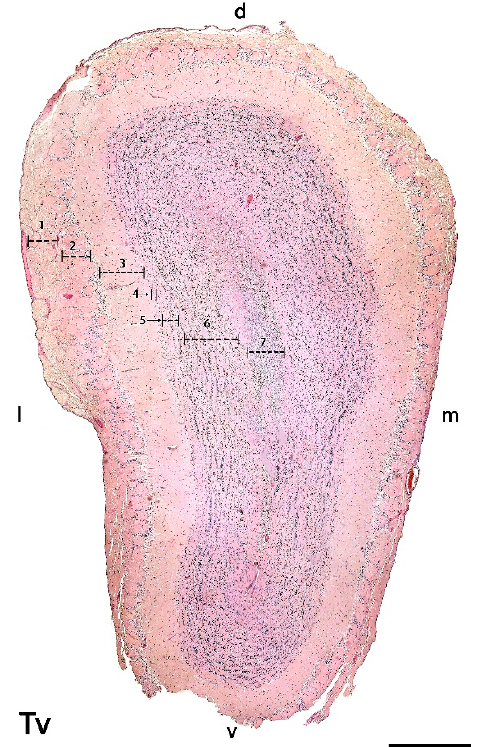
Figure 2. Transverse section of the main olfactory bulb of the meerkat stained by hematoxylin-eosin. From superficial to deep the following layers are identified: 1. Olfactory nerve layer (ONL), 2. Glomerular layer (GlL), 3. External plexiform layer (EPL), 4. Mitral layer (ML), 5. Internal plexiform layer (IPL), 6. Granular layer (GrL), 7. Subventricular zone (SVZ). d, dorsal; l, lateral; m, medial; v, ventral. Scale bars: 600 μ m. Tv, Transverse.